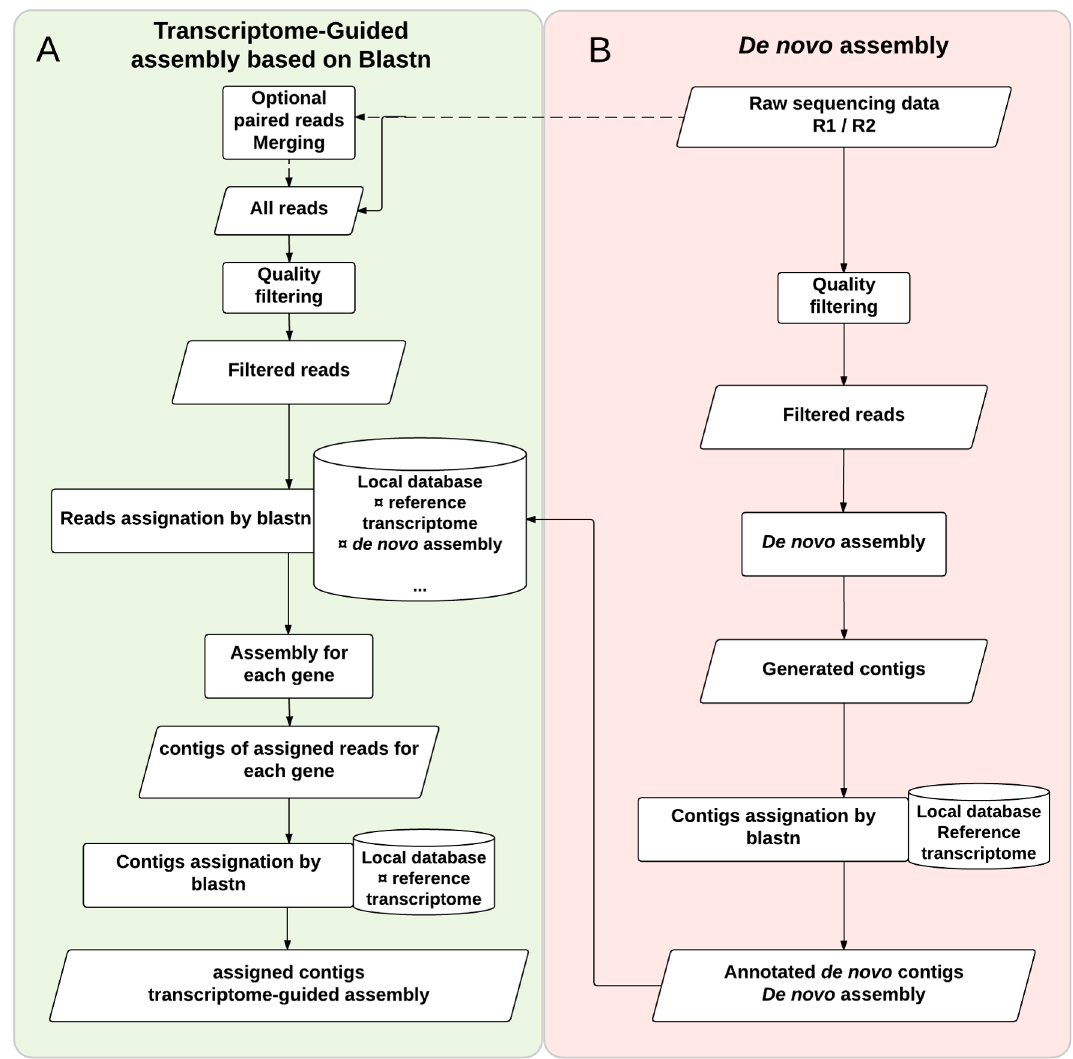
Fig 1. Transcriptome-guided assembly pipeline. We present the pipelinefor transcriptome assembly and contig assignment.(A) The transcriptome-guided assembly per se (green background) combinesa read assignment step based on blastn, making use of a local databasemerging the related reference transcriptome and de novo assembly of the query transcriptome. (B) The de novo assembly (red background) with a blastn annotationof generated contigs to obtain a de novo assembly for the inferred transcriptome. Cylindersrepresent the database, rectanglesrepresent analyticalsteps in the processes, and parallelograms correspond to results. Note that the dashedlines represent optionalsteps in the pipelines.